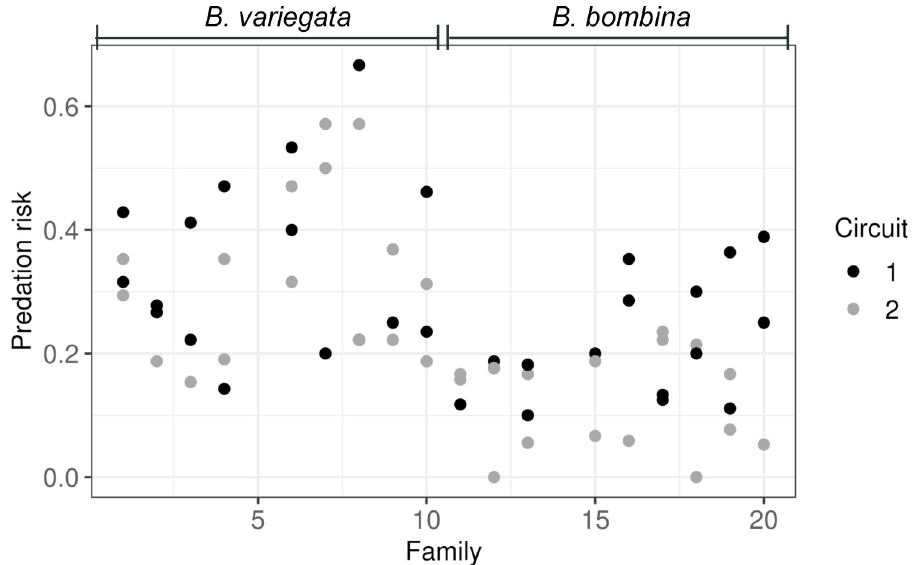
Fig 3. Predation risk per rearing compartment arrayed by family. B . variegata : families 1–4 and 6–10, B . bombina : families 11–13 and 15–20.